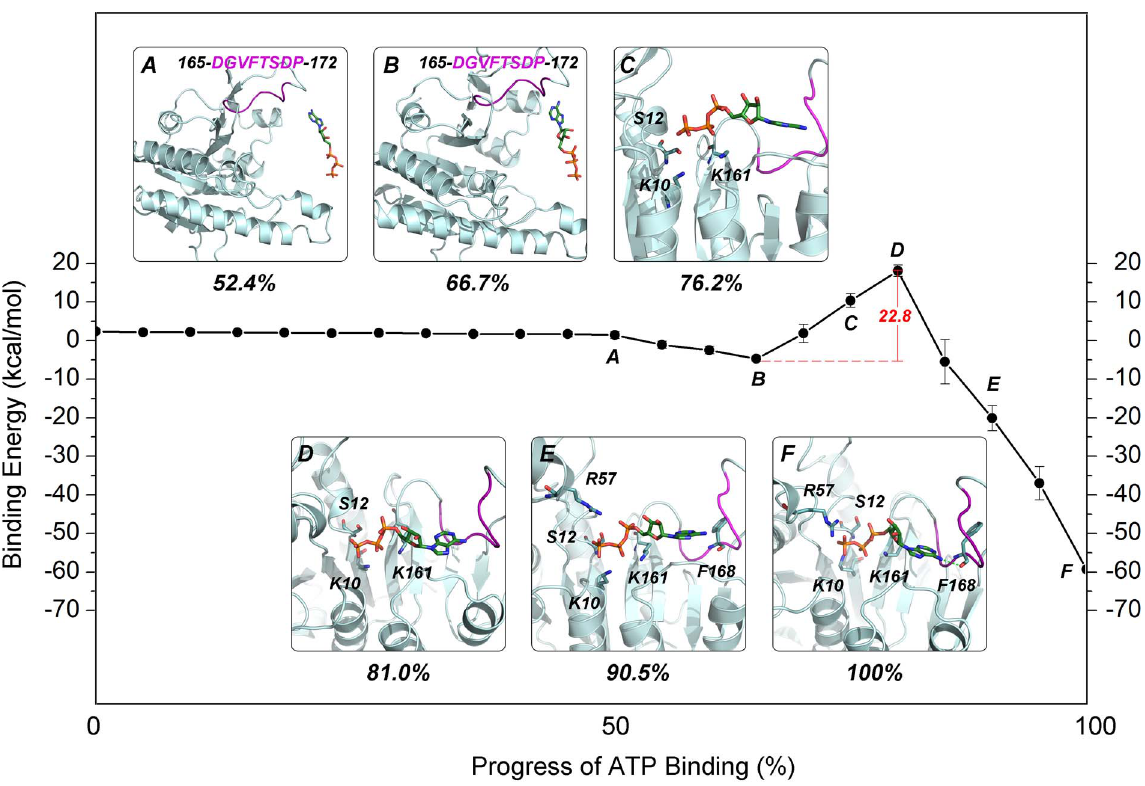
Figure 6. The energy landscape of ATP binding to the substrate ATP-binding site of the UMP kinase as a function of the progress of ATP binding. (A) The six snapshots of the substrate ATP-binding pathway represent the following configurations: A, the unbound state; B, the ‘‘encounter complex’’; C, an intermediate state in which ATP does not interact with Lys10, Ser12 and Lys161; D, the relatively high-energy state; E; an intermediate state in which ATP interacts with Lys10, Ser12, Arg57, and Lys161; F, the fully bound state. The 165-DGVFTSDP-172 motif of UMP kinase in the recognition of the adenine moiety of ATP is shown in magenta. The ATP and its interacting residues are shown as sticks, whereas subunit A of the UMP kinase is shown in pale cyan. The green dashes represent hydrogen bonds. The hydrogen atoms are not displayed for clarity. The error bars represent standard deviations of binding energies for the 20 snapshots from 20 trajectories.